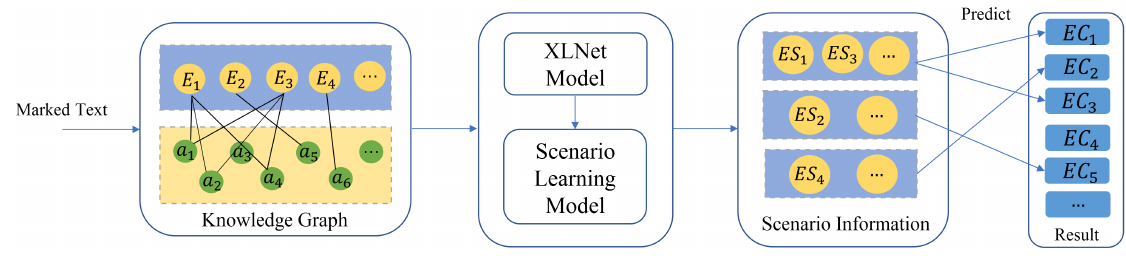
Figure 2. Event prediction model.